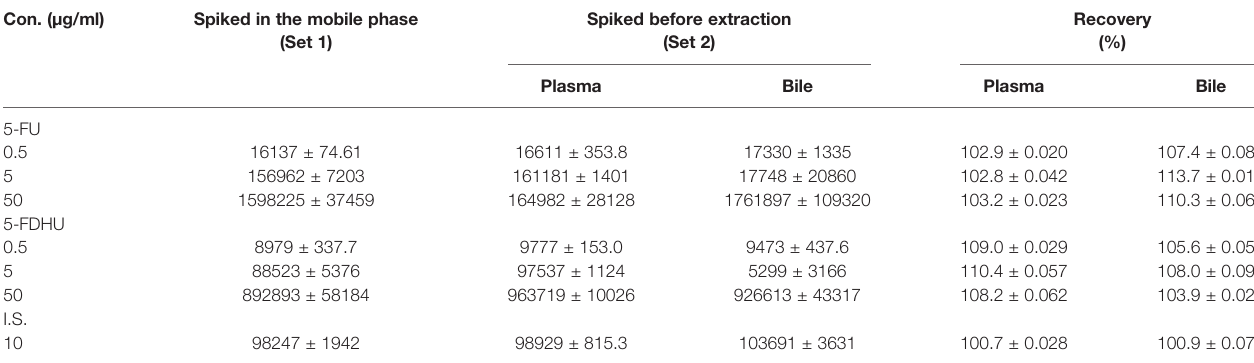
TABLE 2 | Extraction recoveries of 5-FU, 5-FDHU and amoxicillin (I.S.) from rat plasma and bile. Con.